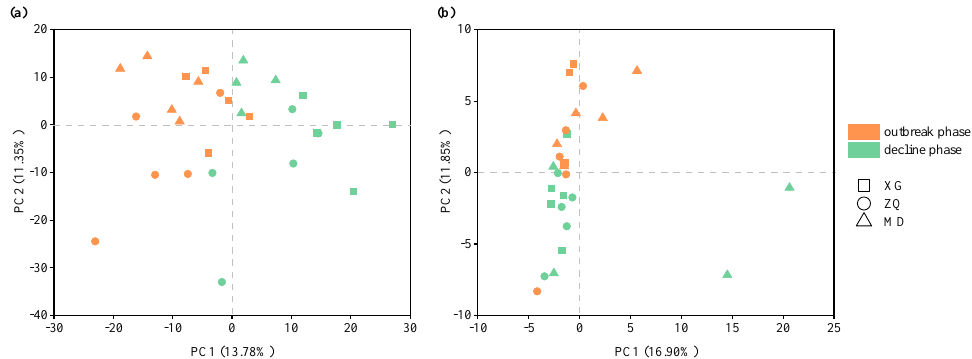
Figure 3. Principal component analysis (PCA) of bacterial ( a ) and archaeal ( b ) communities at the OTU level during the green tide.